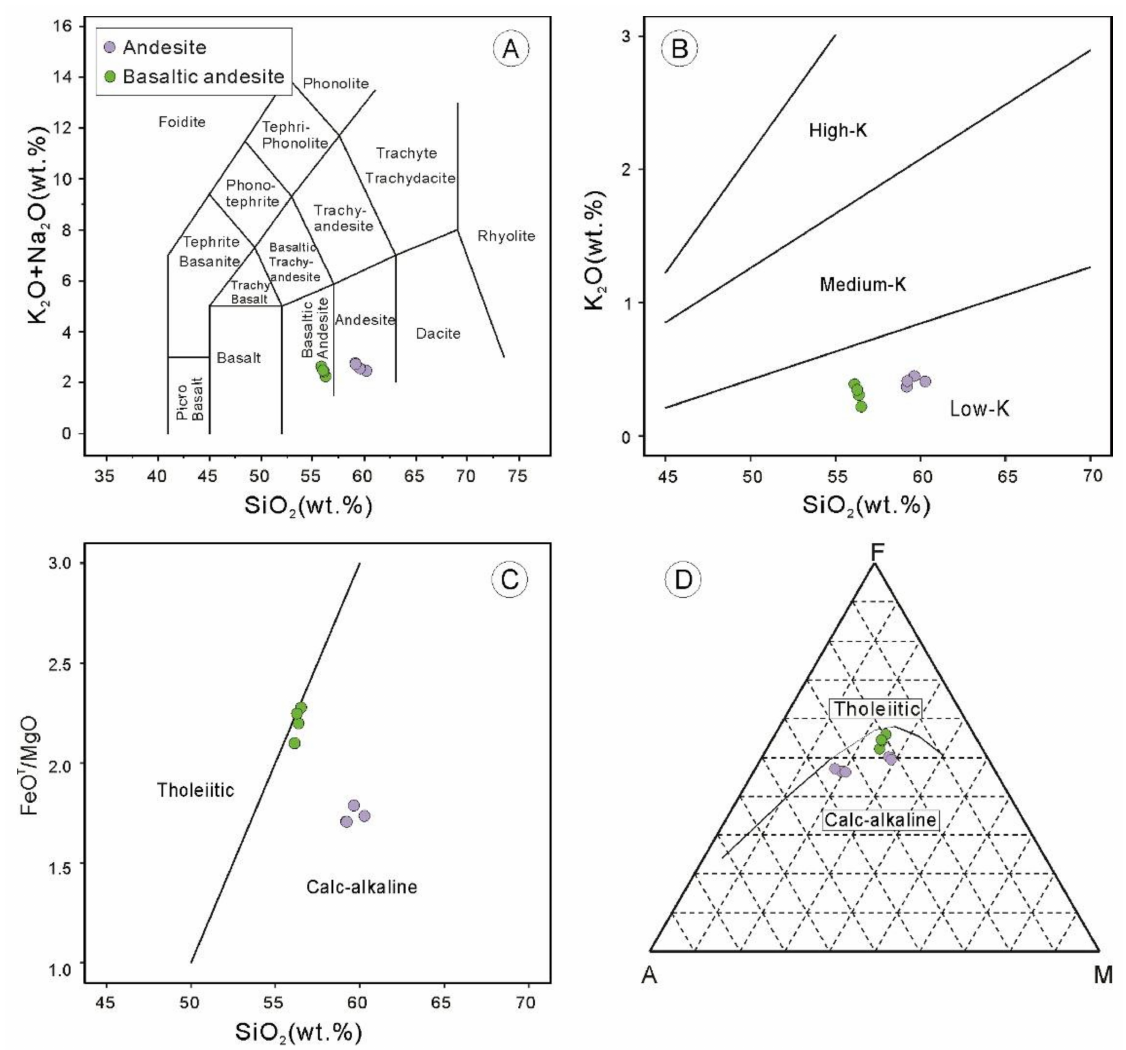
Figure 5. Diagrams of ( A ) (Na 2 O + K 2 O) vs. SiO 2 [42], ( B ) K 2 O vs. SiO 2 [43], ( C ) FeO T /MgO vs. SiO 2 [3], and ( D ) Alkali- FeO T -MgO (AFM)